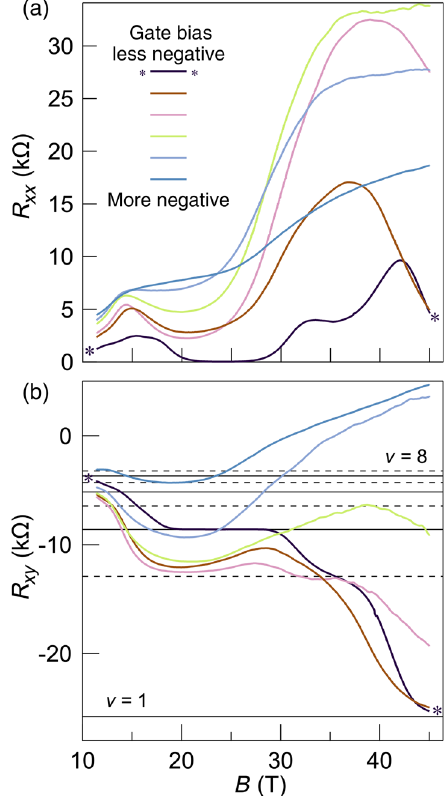
FIG. 3. (a) R and (b) R data under large negative bias xx xy ranging from − 4 to − 11 V. The dark purple traces marked with asterisks are carried over from Figs. 1(c) and 1(d) for comparison. In (b), odd (even) filling factors are indicated by solid (dashed) lines.